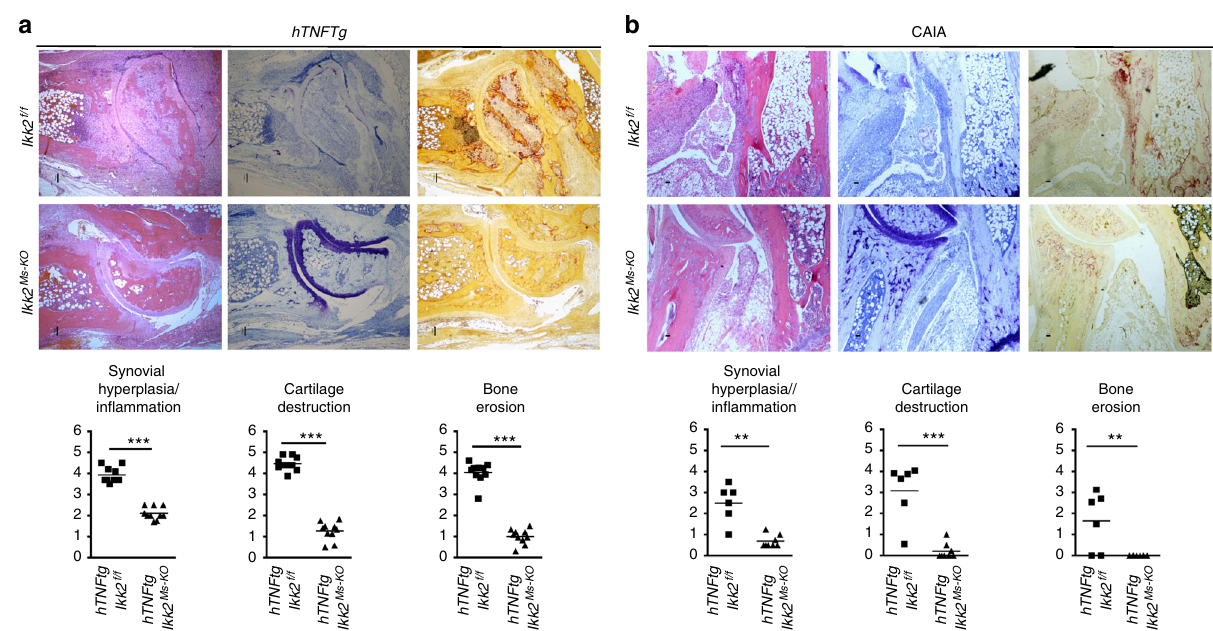
Fig. 2 Mesenchymal IKK2-dependent signals promote arthritic manifestations in TNF-mediated arthritis. a Representative histological images of H&E, Toluidine Blue (TB) and Tartrate-Resistance Acid Phosphatase (TRAP) stained ankle joint sections and histological score of synovial hyperplasia, cartilage destruction and bone erosion of hTNFtg Ikk2 f/f and hTNFtg Ikk2 Ms-KO mice ( n = 10; age: 11 weeks). b Representative histological images of H&E-, TB- and TRAP-stained ankle joint sections and histological score of synovial hyperplasia, cartilage destruction and bone erosion of Ikk2 f/f ( n = 7) and Ikk2 Ms-KO mice ( n = 8) subjected to CAIA at the peak of disease (Day 8). (3 experiments, n = 20 – 22 mice per genotype). Scale bar: 100 and 50 μ m. Data are presented as the mean ± SEM. ** P < 0.01 and *** P < 0.001, by two-tailed Student ’ s t